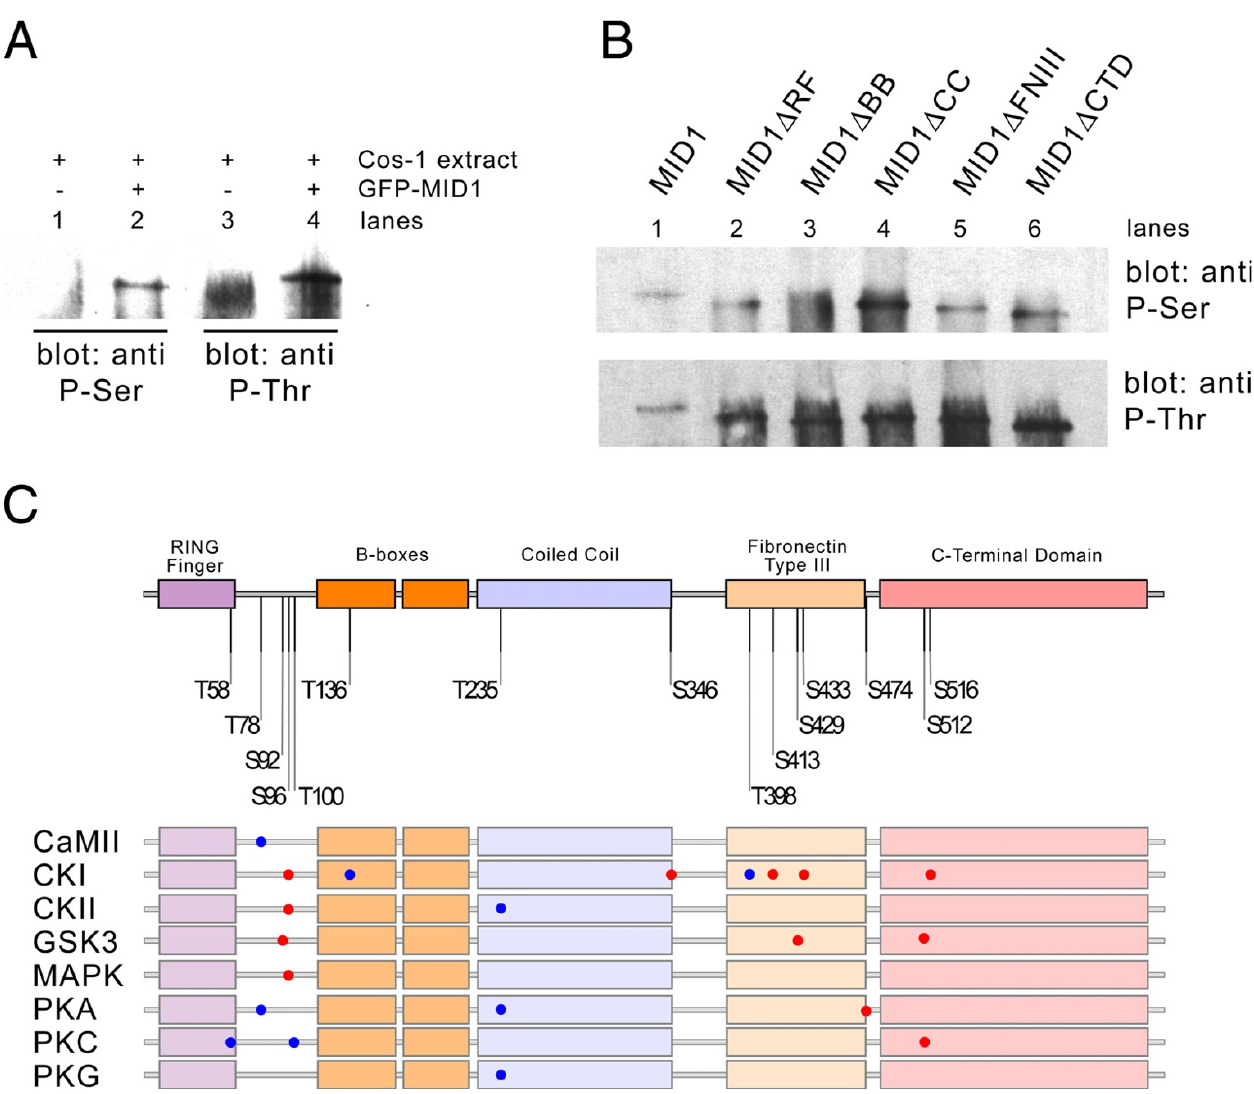
Figure 5 MID1 contains phosphorylated serine and threonine residues. (A) Extracts from untransfected Cos1 cells (lanes 1 & 3) or Cos1 cells transfected with GFP-MID1 (lanes 2 & 4) were immunoprecipitated with anti-GFP antibody/protein-A sepharose beads and analysed by western blot analysis using either an anti-phosphoserine antibody (lanes 1 & 2) or anti-phosphothreonine anti- body (lanes 3 & 4). Protein bands in lanes 2 and 4 indicated that GFP-MID1 contains both phosphoserine and phosphothreo- nine residues. (B) Domain-specific deletions of MID1 were used in an attempt to crudely map locations of the phosphorylated serine and threonine residues. Shown are extracts from Cos1 cells transfected with full length GFP-MID1 (lane 1), GFP- MID1 ∆ RF (lane 2), GFP-MID1 ∆ BB (lane 3), GFP-MID1 ∆ CC (lane 4), GFP-MID1 ∆ FNIII (lane 5), and GFP-MID1 ∆ CTD (lane 6). The samples were immunoprecipitated with anti-GFP antibody/-protein-A sepharose beads, separated on 8% SDS polyacryla- mide gels, transferred to nitrocellulose membranes and blotted with anti-phosphoserine antibody (top panel) or anti-phospho- threonine antibody (bottom panel). (C) Computer assisted detection of potential serine/threonine phosphorylation sites in MID1. Potential serine/threonine kinase consensus phosphorylation sites in MID1 were identified using NetPhos 2.0 software [38]. Examination of a multiple alignment of available MID1 and MID2 sequences was carried out to identify fully conserved putative phosphorylation sites. A diagrammatic representation of this analysis shows 16 conserved sites depicted as dots (red for serine and blue for threonine) along the length of a representative MID1 protein (numbered residue positions are also depicted at the top of diagram). The actual kinases that recognise the residues are listed on the left of the figure; CaMII (R-X- X- S / T -X), CKI (Sp/Tp-X 2–3 - S / T -X), CKII (X- S / T -X-X-D/E), GSK3 (X- S / T -X-X-X-Sp), MAPK (P-X-S/T-P), PKA (R-X 1–2 - S / T - X), PKC (X- S / T -X-R/K), PKG ((R/K) 2–3 -X- S / T